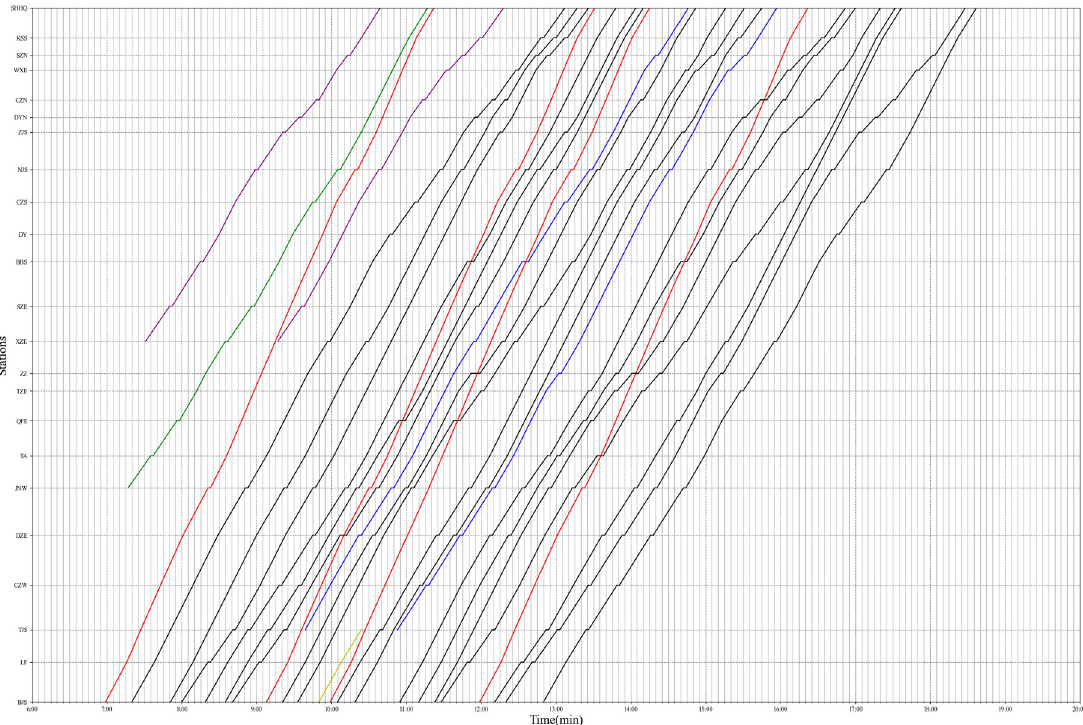
Fig 9. Time-distance diagram of optimized timetable.